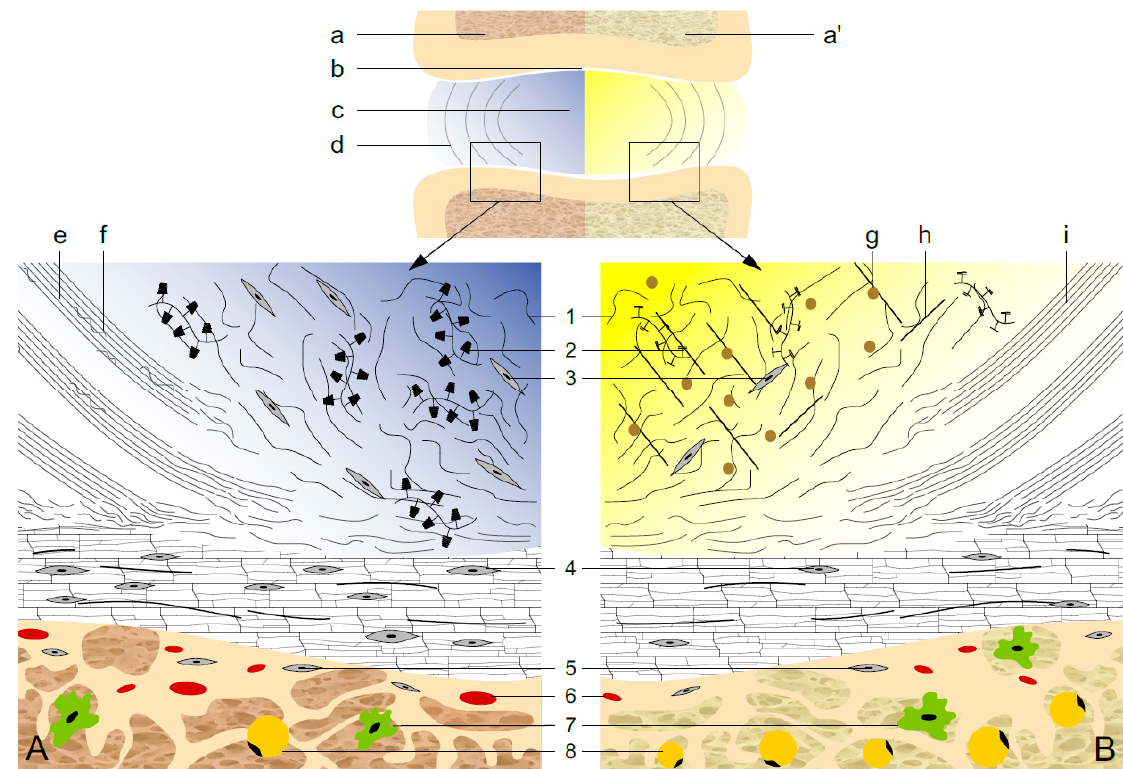
Figure 1. The intervertebral disc. Upper panel—the intervertebral disc flanked with adjacent vertebrae. Within the vertebrae is ( a ) red, hematopoietic bone marrow, or ( a’ ) yellow bone marrow adipose tissue. The intervertebral disc consists of ( b ) bilayer of cartilage endplate and porous subchondral bony plate, ( c ) central semi-fluid nucleus pulposus, and ( d ) fibrous annulus fibrosus. Lower panel—scheme of ( A ) healthy intervertebral disc of a young individual with hematopoietic bone marrow, and ( B ) degenerated intervertebral disc with bone marrow adipose tissue. Nucleus pulposus is rich in ( 1 ) collagen type II and ( 2 ) water-attracting proteoglycans with attached glycosaminoglycans—depicted as bottlebrush structures. Depending on the age, nucleus pulposus contains between 70% and 90% of water (bluish color of the nucleus pulposus in panel A). The degenerated intervertebral disc (panel B), hallmarked with lower hydration, contains ( g ) accumulated advanced glycation end-products (yellowish discoloration). In the nucleus pulposus are its principal chondrocyte-like cells ( 3 ). Ageing disc (panel B) shows reduced cellularity, loss of ( 1 ) collagen type II, and increase in ( h ) collagen type I content. “Young” annulus fibrosus (panel A) in inner section contains collagen ( e ) type I and ( f ) type II, whereas degenerated annulus fibrosus (panel B) shows in ( i ) inner section loss of collagen type II. The cellularity of ( 4 ) cartilage endplate is decreasing with advancement of degeneration. In the subchondral bone are ( 5 ) osteoblasts, ( 6 ) capillary endings, ( 7 ) immune cells, and ( 8 ) adipocytes.